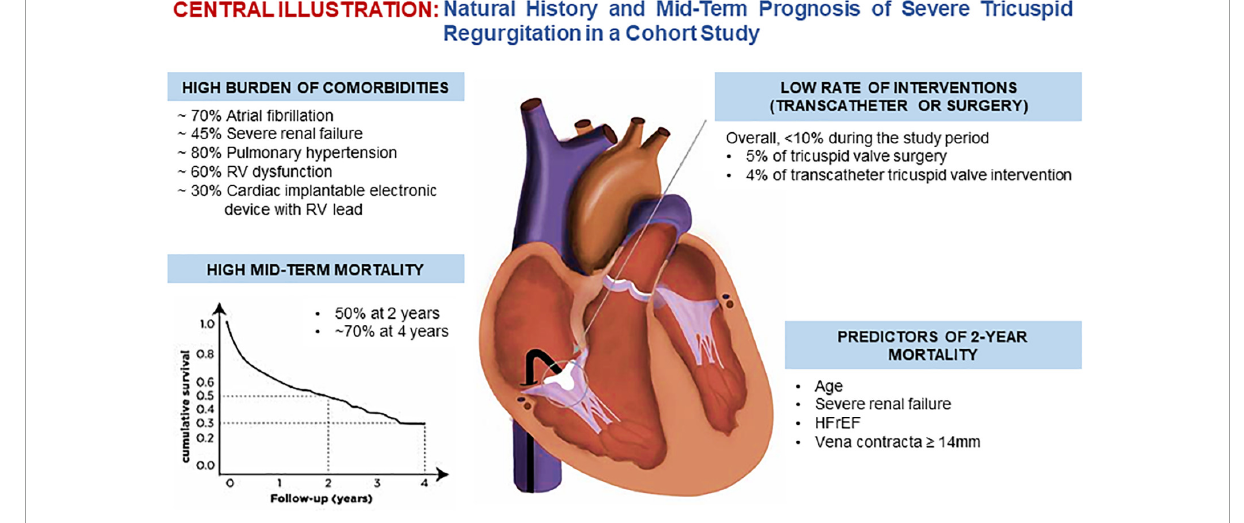
FIGURE1 Central illustration.